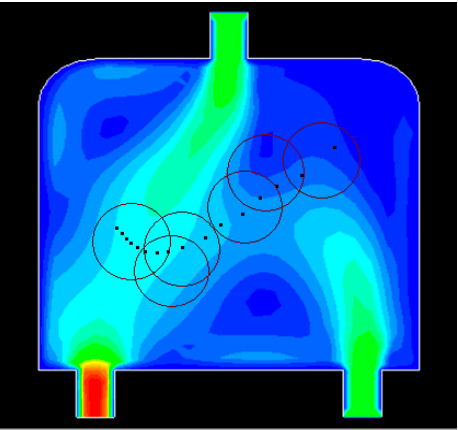
Figure 12. The distribution of events and sensors at